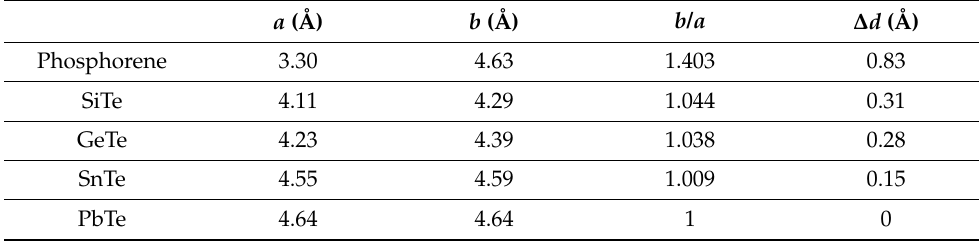
Figure 1. Top and side views of the monolayer ( a ) XTe (X = Si, Ge, Sn) and ( b ) PbTe structures. Δ d is the relative displacement between the group-IV and Te atoms along the y direction. The unit cell is indicated by a dashed rectangle. Table 1. Structural parameters of phosphorene and group-IV telluride monolayers: lattice constants ( a , b ), lattice constant ratios ( b / a ), and relative displacements ( ∆ d ) between group-IV and Te atoms along the y direction are